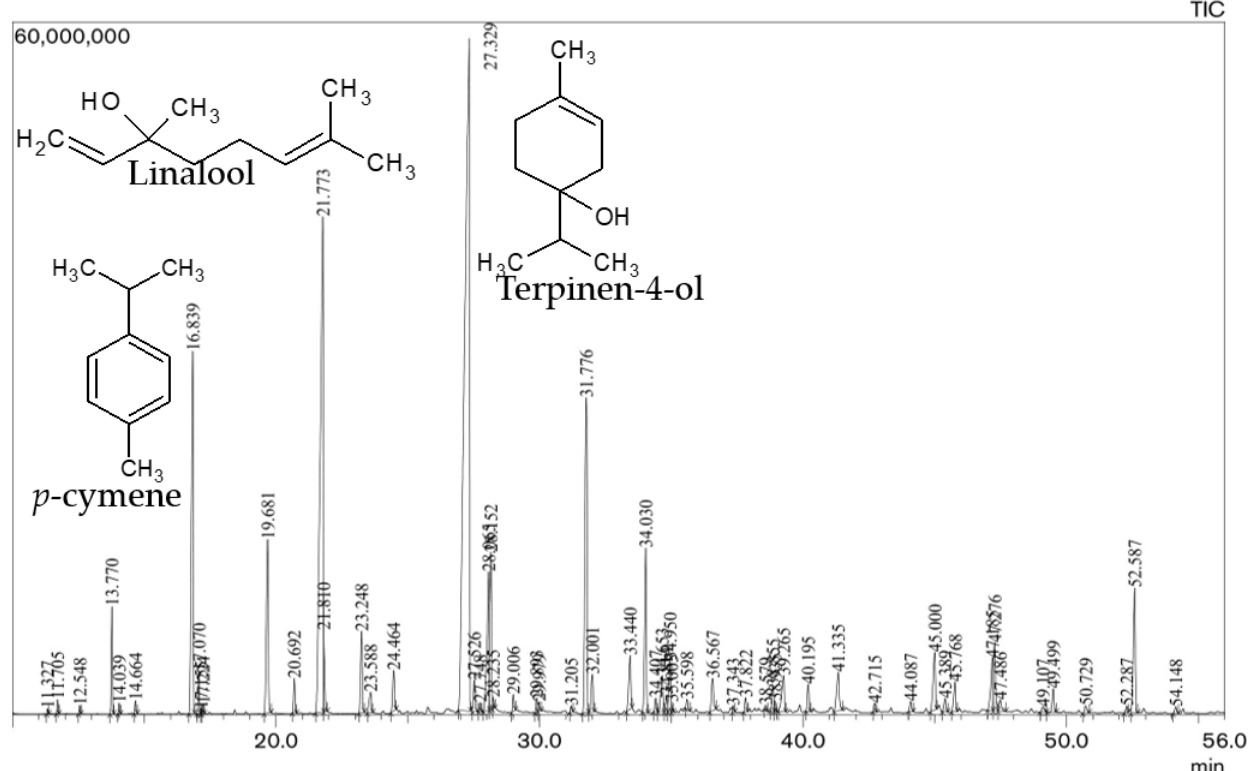
Molecules 2022 , 27 , x FOR PEER REVIEW Figure 1. Typical GC-MS chromatogram of O. majorana L. essential oil. Figure 1. Typical GC-MS chromatogram of O. majorana L. essential oil.